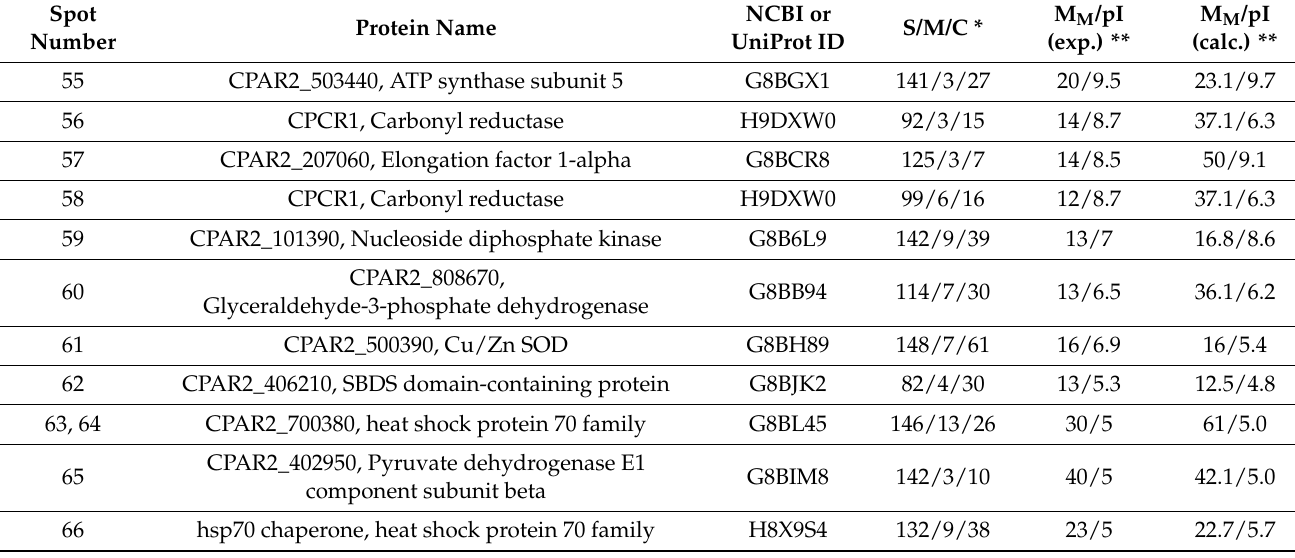
* S/M/C—the Mascot Score is an indicator of conformity or “scorecard”; match peptides are the number of matched peptides; coverage is the percentahe of the complete amino acid sequence of the protein using the identified peptides.** M M /pI (exp.) are the obtained estimates according to electrophoretic mobility in the DE, M M /pI (calc.) are the estimates made using the data on the amino acid sequence, taking into account signal peptide removal, but with no consideration of other post-synthetic modifications using the ExPASy Compute pI/M w tool